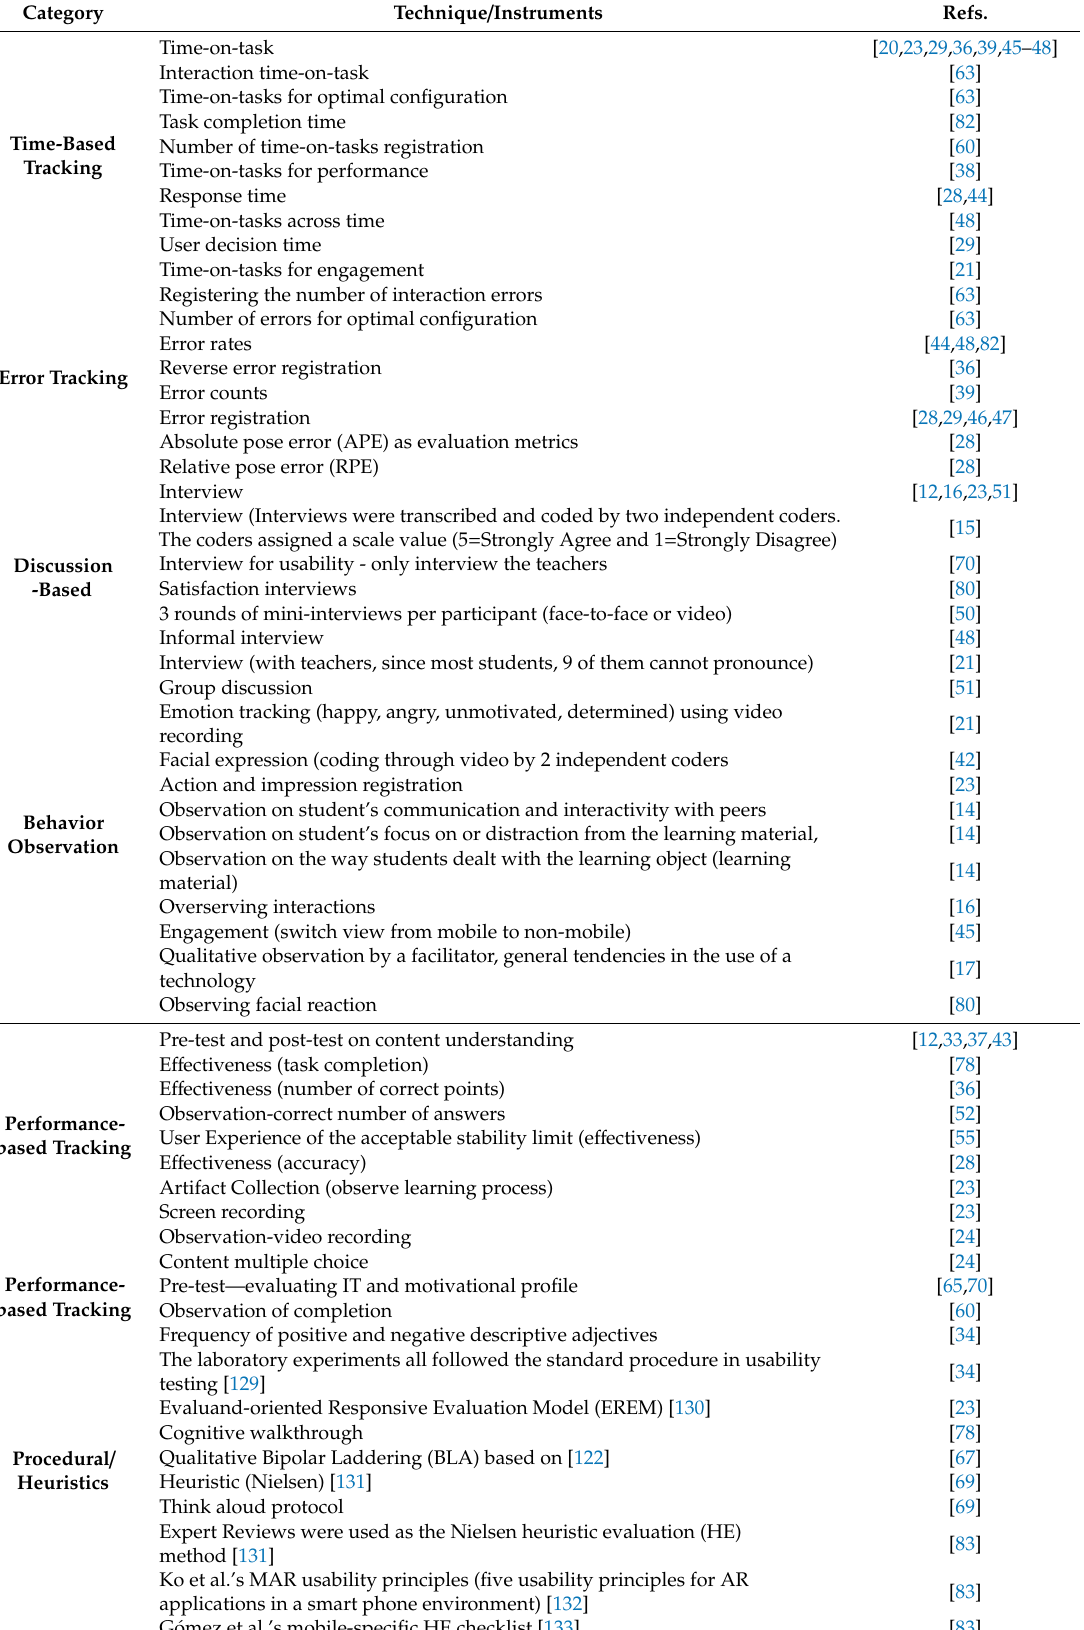
Table 13. Usability instruments (pre-determined categories by